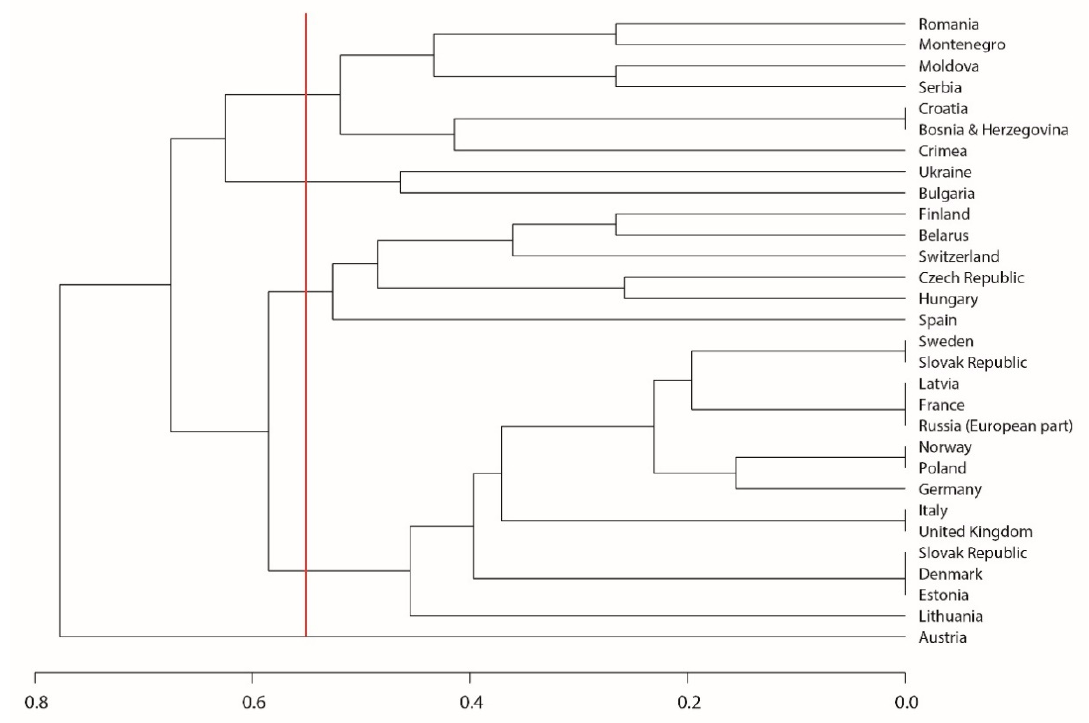
Figure 2. Results of hierarchical cluster analysis (unweighted pair group method with arithmetic mean, UPGMA) showing the degree of similarity of European countries where Cypripedium calceolus is present, using Bray-Curtis distances of the factors that have been identified as threats at each country. The vertical red line denotes the limit that led to the identification of the five groups of countries.